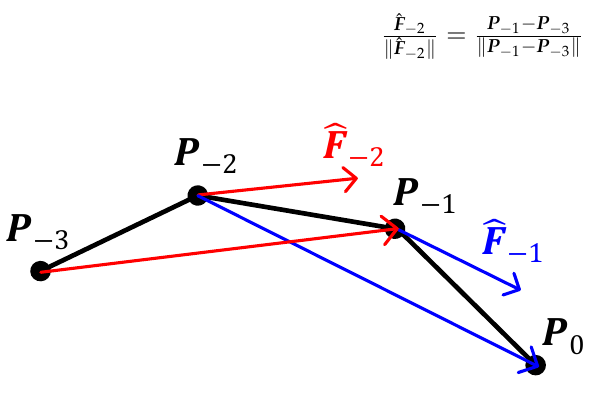
Figure 3. The principle for solving the approximation of the speed. The X-axis component of the above equation